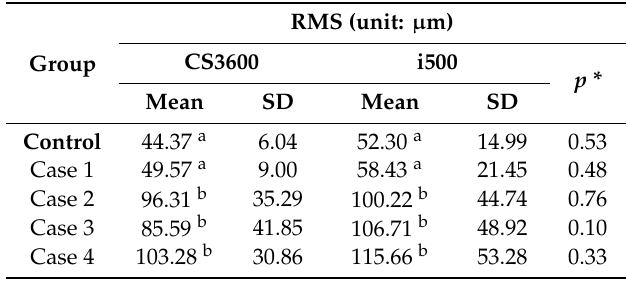
Table 2. Mean and standard deviation (SD) of root mean square (RMS) values.